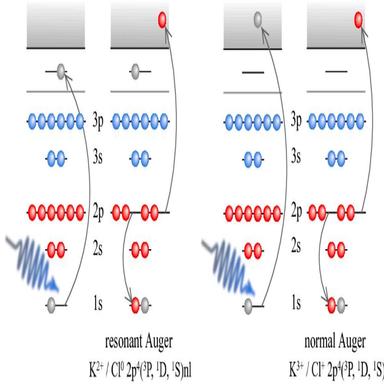
Schematic representation of the resonant (left) and normal (right) Auger processes of the isoelectronic K+ and Cl− ions.